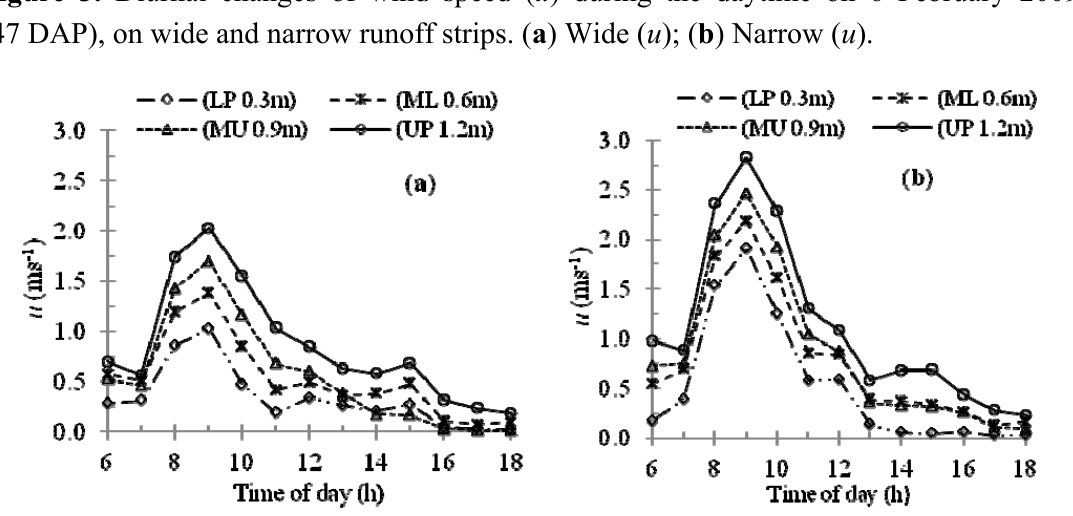
Figure 3. Diurnal changes of wind speed ( u ) during the daytime on 6 February